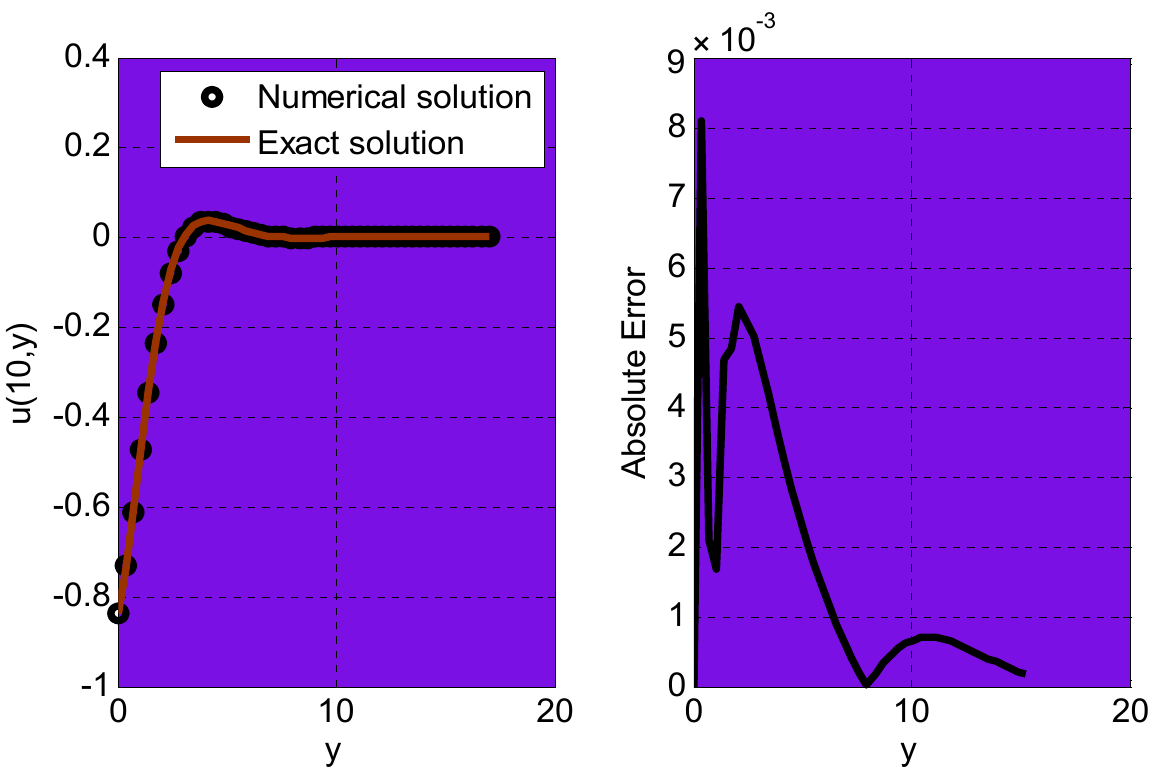
Figure 5. Solution and absolute error for Stokes’ second problem by Runge–Kutta time discretization scheme using N y = 50, N t = 300, t f =